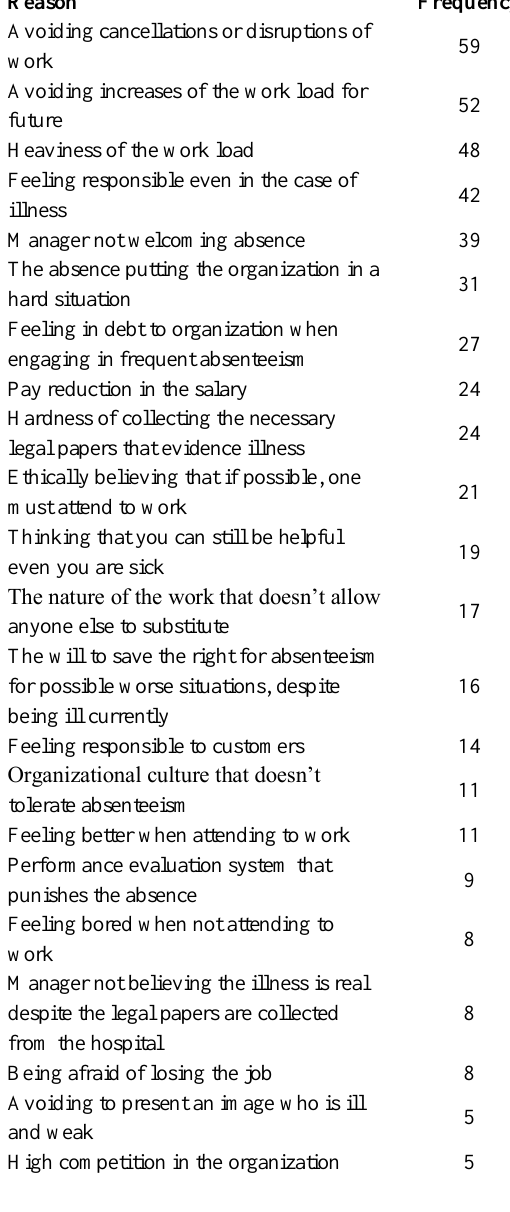
Table 1: Reasons Provided for Presenteeism